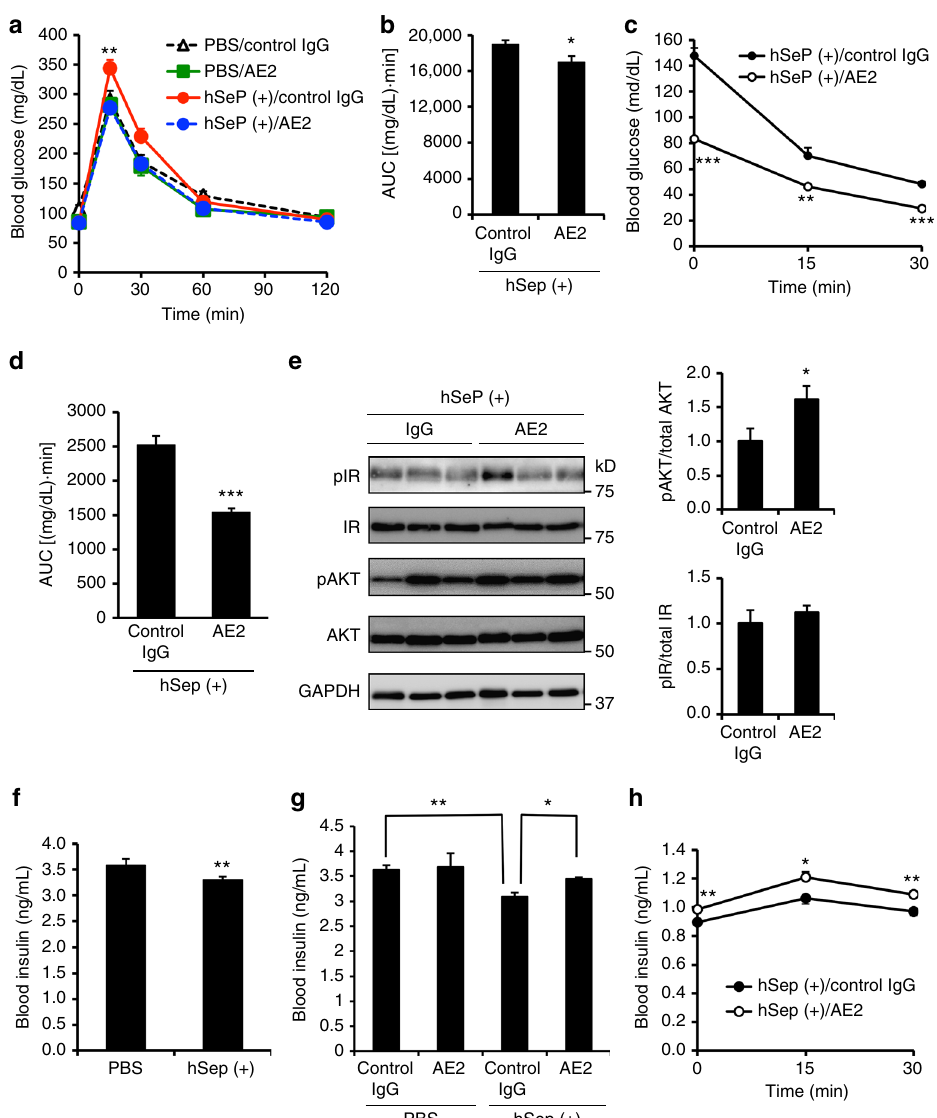
Fig. 3 The SeP-neutralizing Ab improved glucose metabolism impaired by excess SeP. a , b Neutralizing mAb AE2 improved glucose tolerance impaired by human SeP administration in vivo. After the administration of AE2 and hSeP following the scheme of Supplementary Fig. 4a, glucose (1.5 g/kg) was administered, and then blood glucose was determined ( a , n = 6 – 8, means ± s.e.m.). Open triangle, PBS/control IgG; green square, PBS/AE2; red circle, hSeP(+)/control IgG; blue circle, hSeP(+)/AE2. ** P < 0.01, when compared hSeP(+)/control IgG group with other groups, Tukey-ANOVA. Area under the curve for blood glucose levels is shown in b ( n = 6 – 8, means ± s.e.m.). * P < 0.05, Student's t -test. c – e Neutralizing mAb AE2 improved insulin resistance impaired by SeP administration in vivo. After the administration of AE2 and hSeP following the scheme shown in Supplementary Fig. 4a, insulin (0.5 U/kg) was administered, and blood glucose was determined ( c , n = 5 – 8, means ± s.e.m.). ** P < 0.01, *** P < 0.001, Tukey-ANOVA. Area under the curve for blood glucose levels is shown in d ( n = 5 – 8, means ± s.e.m.). *** P < 0.001, Student's t- test. Effect of AE2 mAb administration on phosphorylation of insulin receptor (IR) and Akt in skeletal muscle ( e ). In AE2- and hSeP-treated mice, muscle tissues were excised 15 min after insulin administration (0.5 U/kg), and analysed by western blotting ( n = 5 – 8, means ± s.e.m.). * P < 0.05, Student's t -test. f Blood insulin levels were signi fi cantly decreased by human SeP administration. Blood insulin levels were determined 2 h after second hSeP or PBS administration under feeding conditions ( n = 5, means ± s.e.m.). ** P < 0.01, Student's t- test. g Blood insulin levels were signi fi cantly increased by AE2 administration under feeding conditions ( n = 5, means ± s.e.m.). * P < 0.05, ** P < 0.01, Tukey-ANOVA. h Blood insulin levels were signi fi cantly increased during a glucose-tolerance test. At each designated time, blood insulin was determined ( n = 7 – 8, means ± s.e.m.). * P < 0.05, ** P < 0.01, Tukey-ANOVA ( c , h ). Closed circle, hSeP(+)/control IgG; open circle, inhibitory effects of several mAbs in Jurkat cells (Supplementary immunoreactivity with hSeP-NF, while AA3 had hSeP-CF Figs. 1b and 1c). (Fig. 1c). DC12 did not show distinct immunoreactivity against The treatment of full-length hSeP (FL-hSeP) with plasma either fragment, suggesting that DC12 only recognizes intact hSeP kallikrein results in sequence-limited proteolysis (Arg-235 – Gln- (Fig. 1c). 236 and Arg-242 – Asp-243) 14 , which generated N-terminal To examine the effects of mAbs on the cellular uptake and (hSeP-NF) and C-terminal fragments (hSeP-CF) (Fig. 1b). supply of Se by hSeP, we incubated differentiated C2C12 Binding-inhibitory Abs such as AE2, BD1, BF2 and DH9 had myocytes with various concentrations of hSeP and sodium